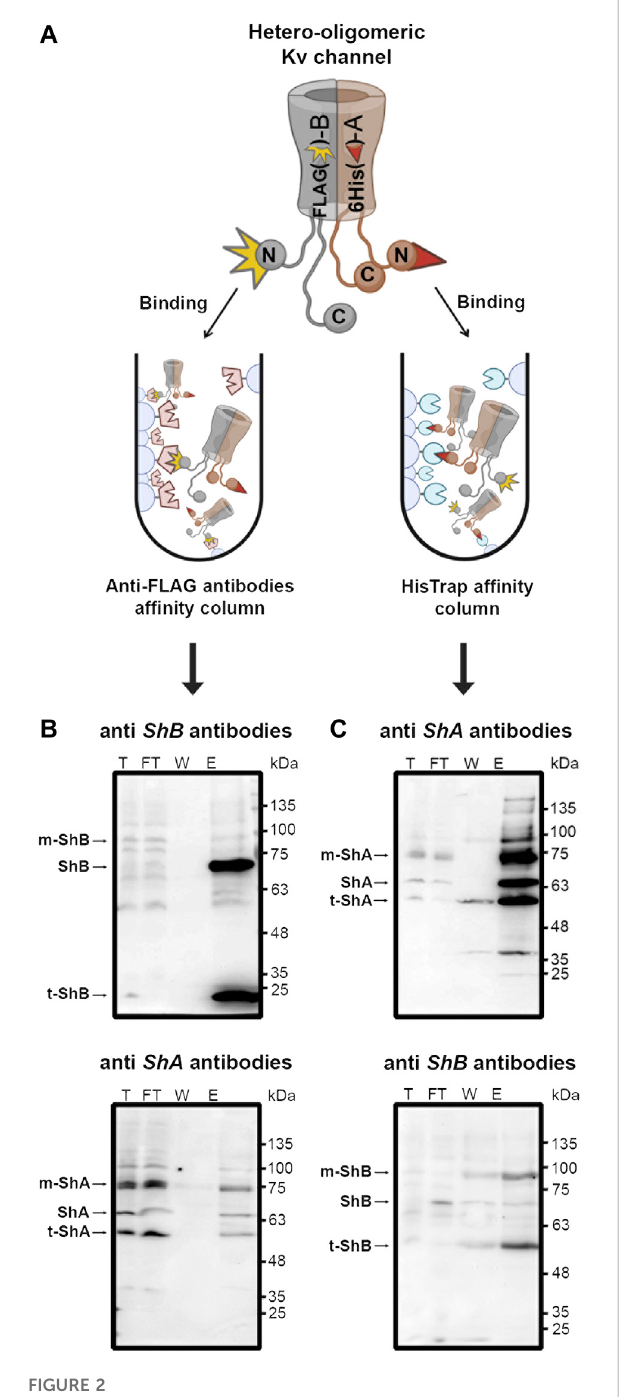
FIGURE 2 Pull-down analysis revealed hetero-oligomeric Kv channel molecules composed of both A and B subunit variants. (A) Schematic representation of the pull-down experimental setup used to detect hetero-oligomeric Kv channel subunit assembly (see text). Brie fl y, the native membrane protein fraction of SH-SY5Y cells expressing a